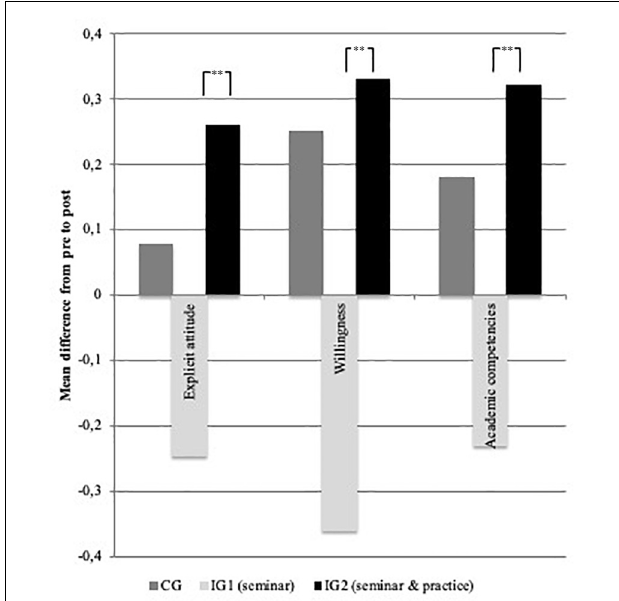
FIGURE 1 | Mean difference from pre to post for overall explicit attitude and for the subscales “willingness to teach inclusively” as well as “promoting academic competencies”; ** p < 0.01.